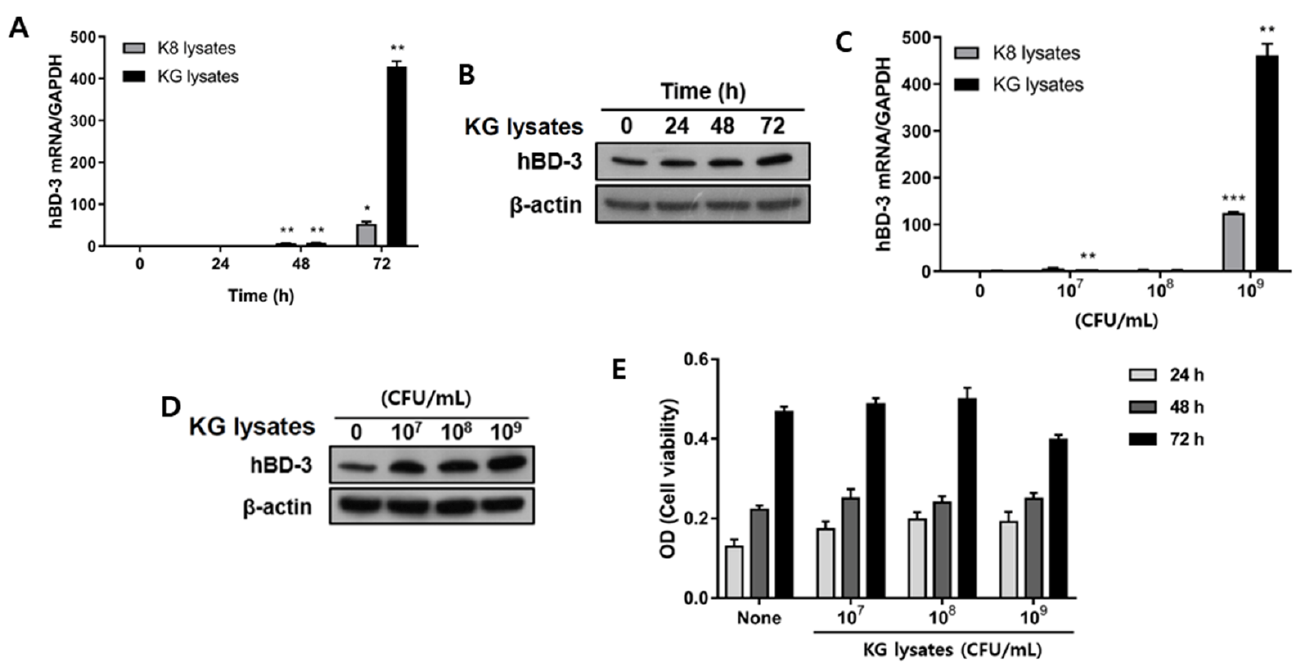
Figure 1. L. plantarum KG lysates increased hBD3 expression in HaCaT cells. HaCaT cells were treated with the indicated doses of K8 lysates and KG lysates for the indicated times. ( A , C ) hBD3 mRNA level was examined by real-time PCR. ( B , D ) hBD3 protein level was examined by Western blot. ( E ) Cell viability assay was performed with HaCaT cells treated with KG lysates. *P<0.05, **p<0.01, and ***p<0.001.